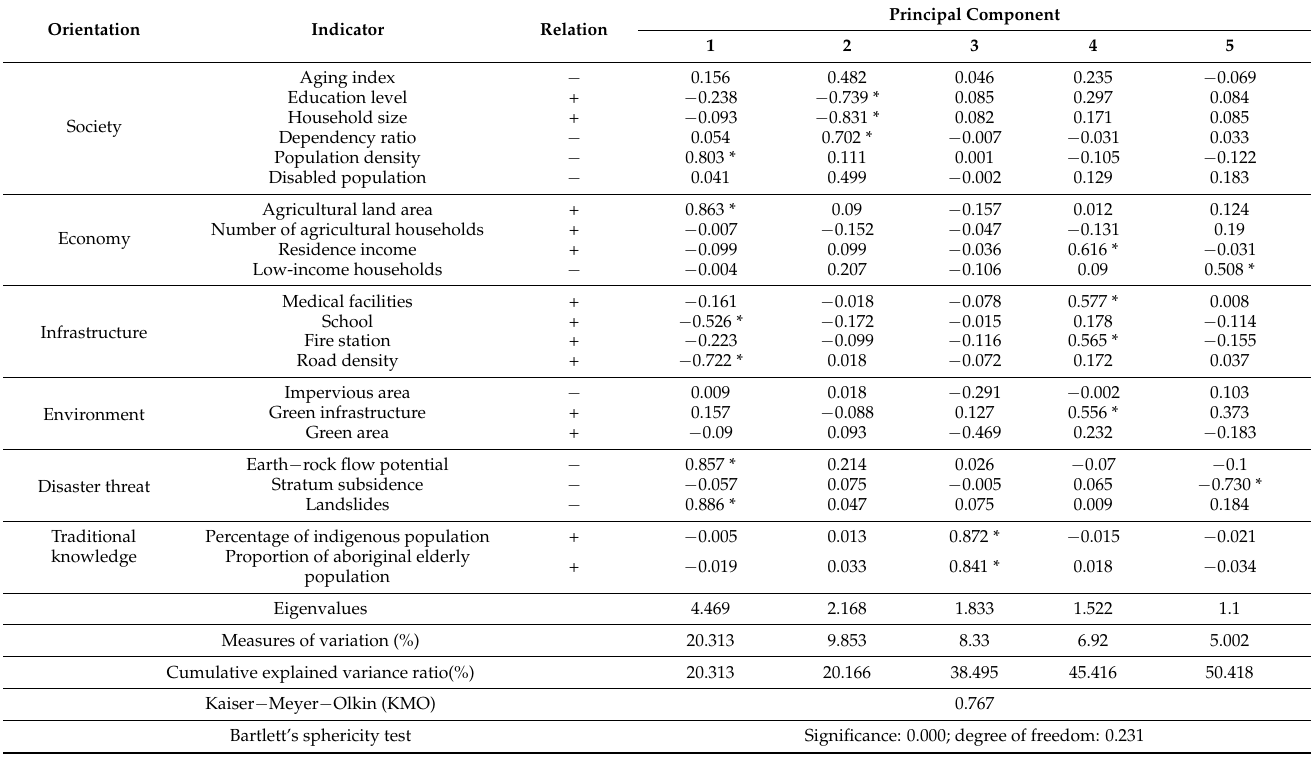
Table 1. Indicator system and Principal Component